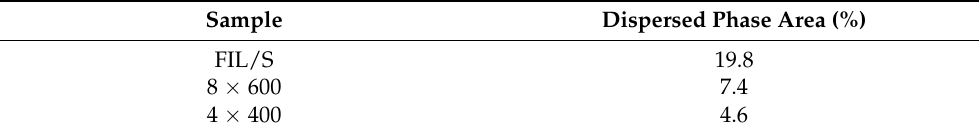
Table 2. Surface fraction attributed to the dispersed phase obtained by image analysis of SEM micrographs.